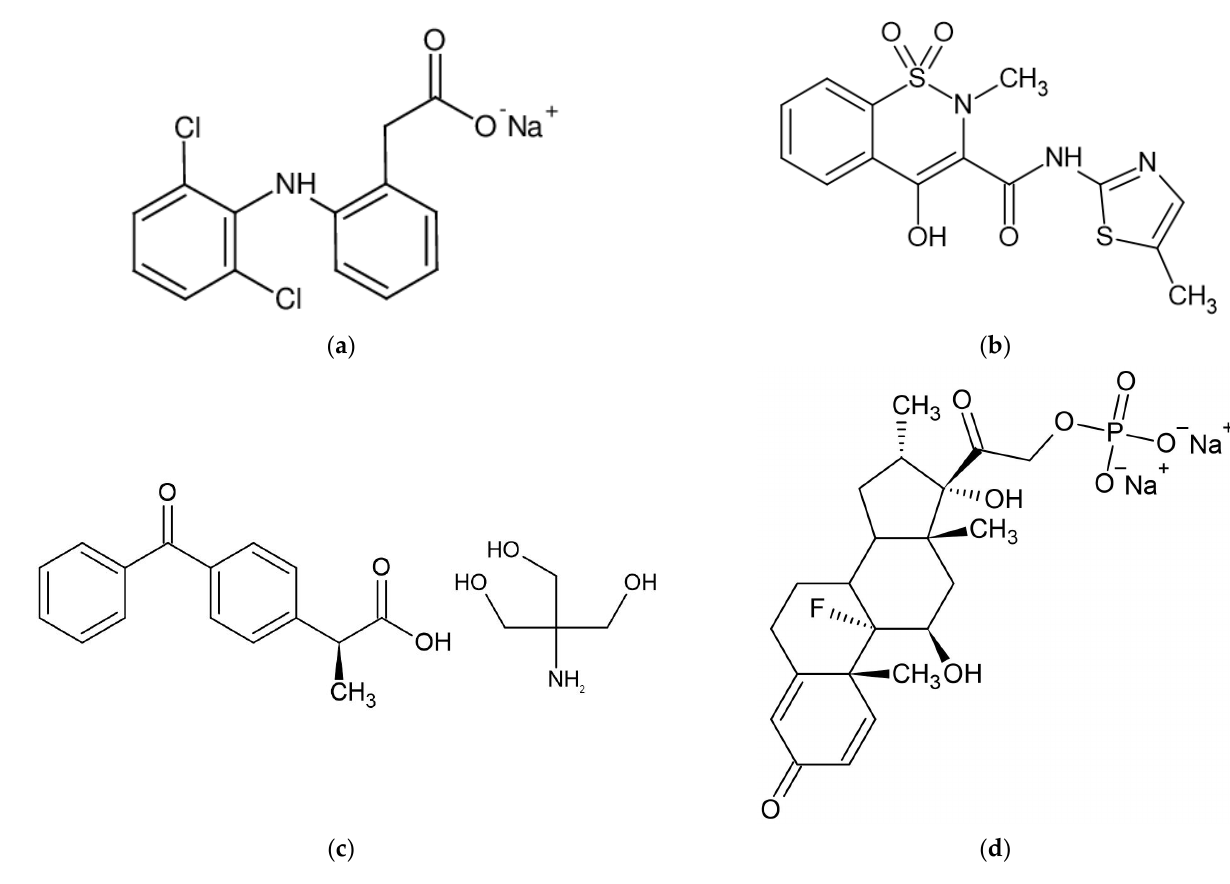
Figure 1. ( a ) Sodium Diclofenac molecule [19]. ( b ) Meloxicam molecule [21]. ( c ) Dexketoprofen trometamol molecule [24]. ( d ) Dexamethasone sodium phosphate molecule [26].